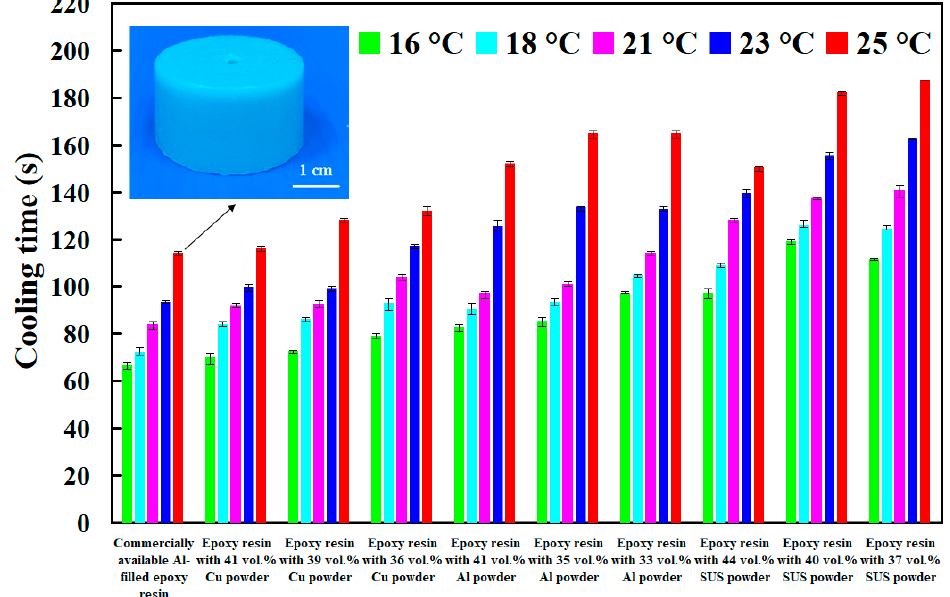
Figure 19. Cooling time of injection molded parts fabricated by ten sets of injection molds cooled with different temperature of cooling water with ultrafine bubbles.